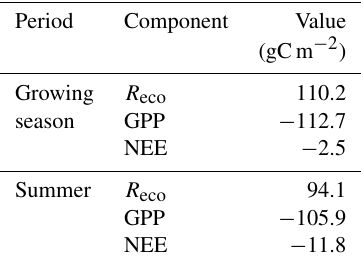
Figure 7. Gross primary productivity (GPP m ) plotted against global radiation ( R g ); red symbols are estimated values according to Eq. (5), and the black symbols are the fitted model. Table 2. Summary of seasonal C fluxes from Kapp Linné. R eco is ecosystem respiration, GPP is gross primary productivity and NEE is net ecosystem